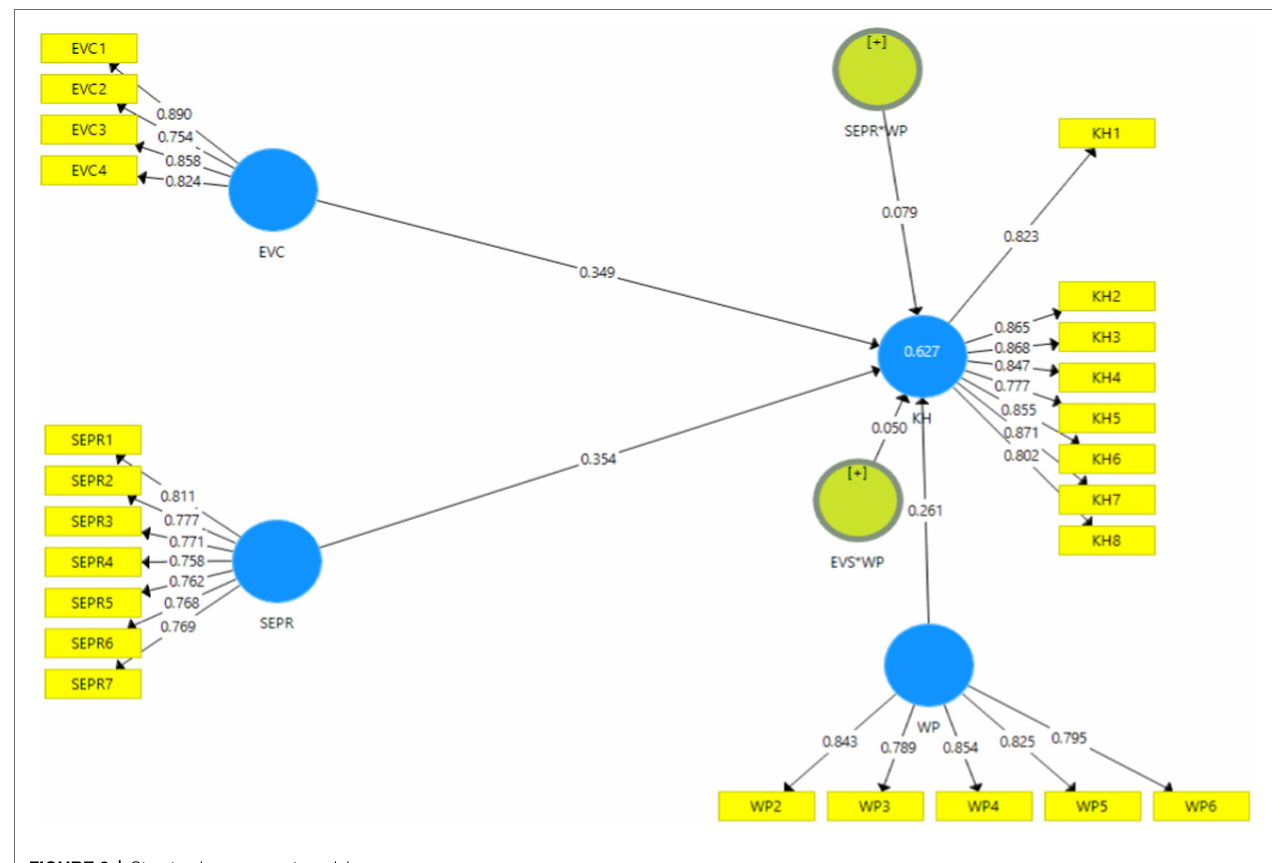
FIGURE 2 | Structural assessment model.